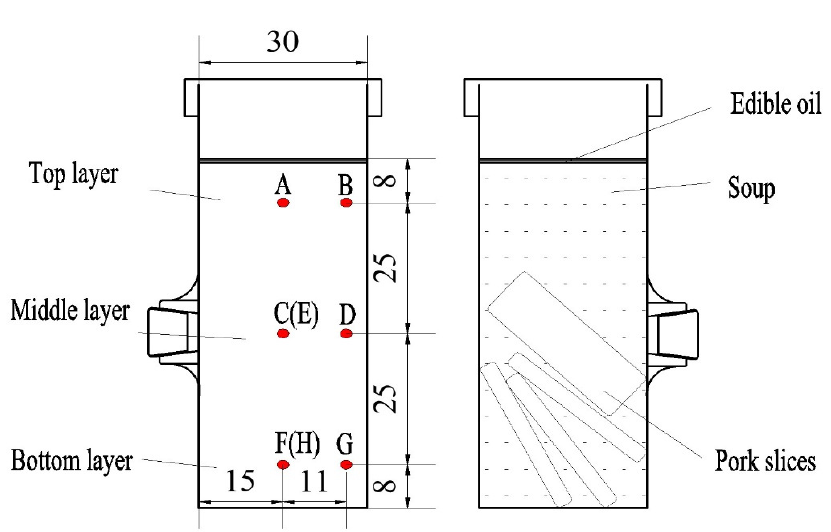
Figure 1. Position of fiber optic sensor in the Teflon container and distribution of the poached spicy pork slice sample in the Teflon container (all dimensions are in mm). Points A, B, C, D, F, and G were used to measure the soup temperature, whereas E and H were used for the pork slices’ internal region.